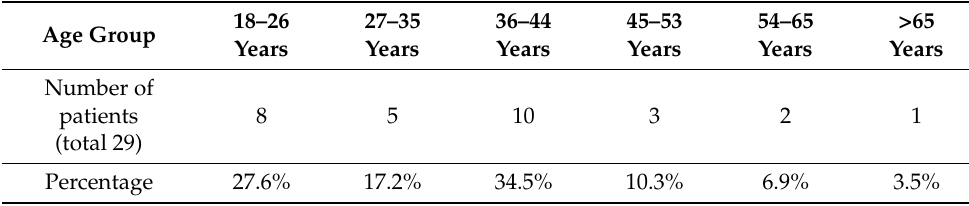
Table 5. Age distribution among participating